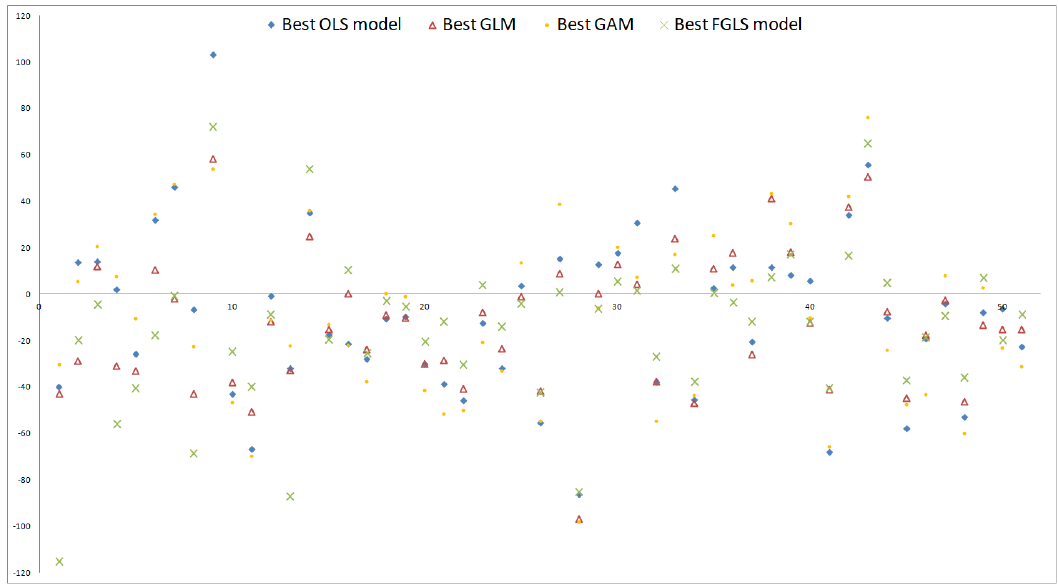
Figure 8. Residual plots on Sobol set. Version February 10, 2020 submitted to Risks